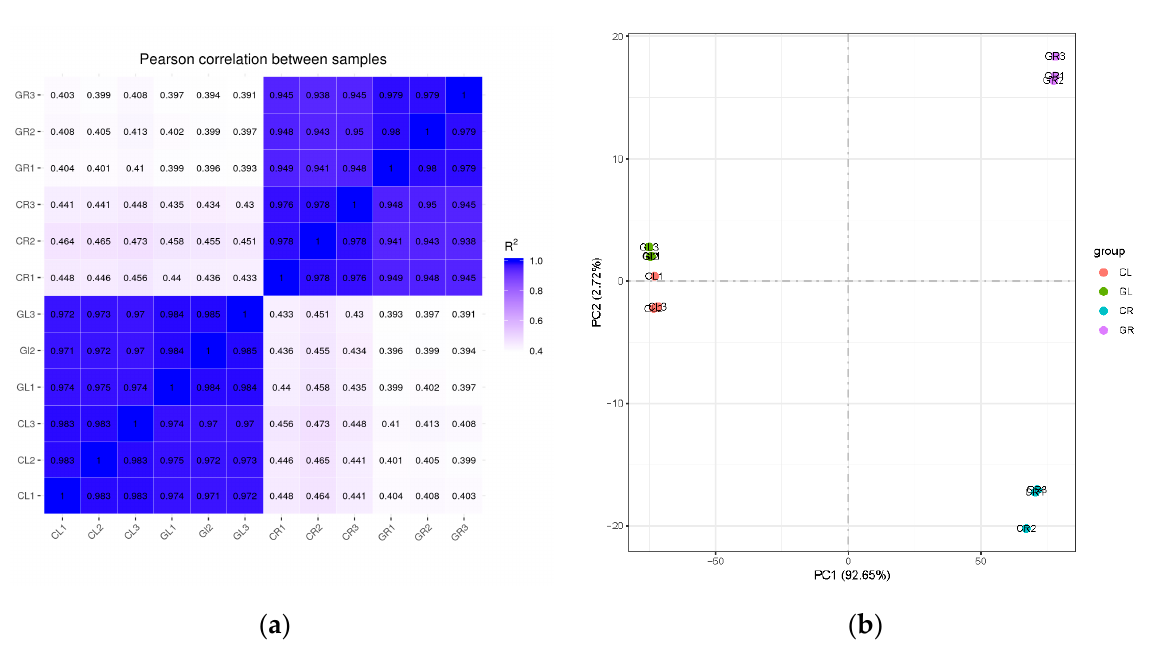
Figure 1. Pearson’s correlation and principal component analysis (PCA). ( a ) Heatmap of correlation matrix showed the correlation coefficient between samples; ( b ) PCA was performed on the biological replicates of each sample set. CL, CR, GL and GR represent the shoots and roots samples of the inorganic N control and the Gln treatment,